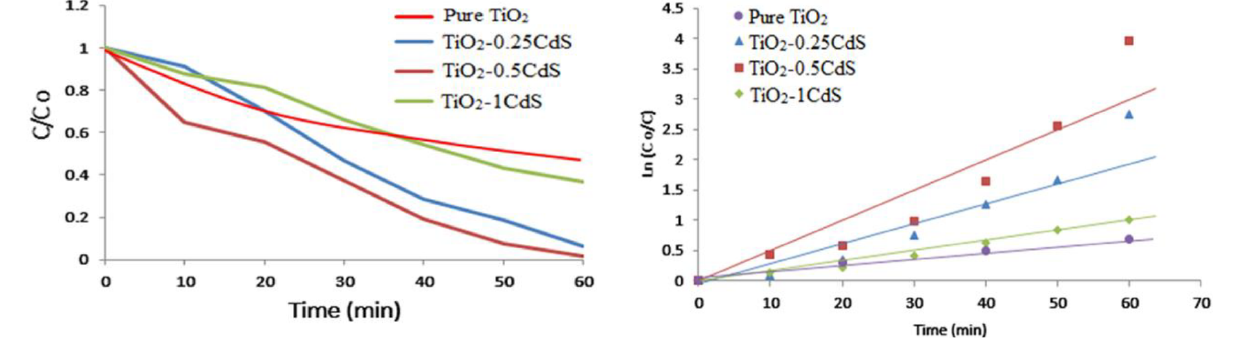
Figure 8: The degradation of (MB) in the first order kinetics as a function of irradiation duration of pure and composite TiO 2 with various CdS